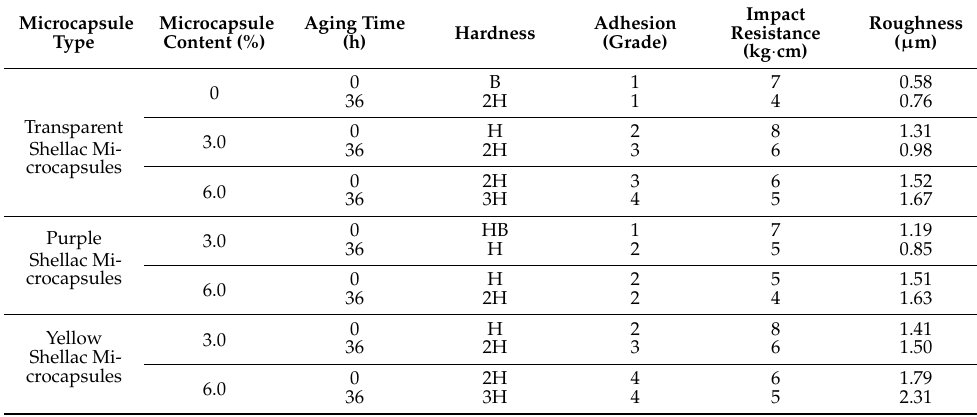
Table 11. The mechanical qualities of the coating on Beli wood before and after aging.